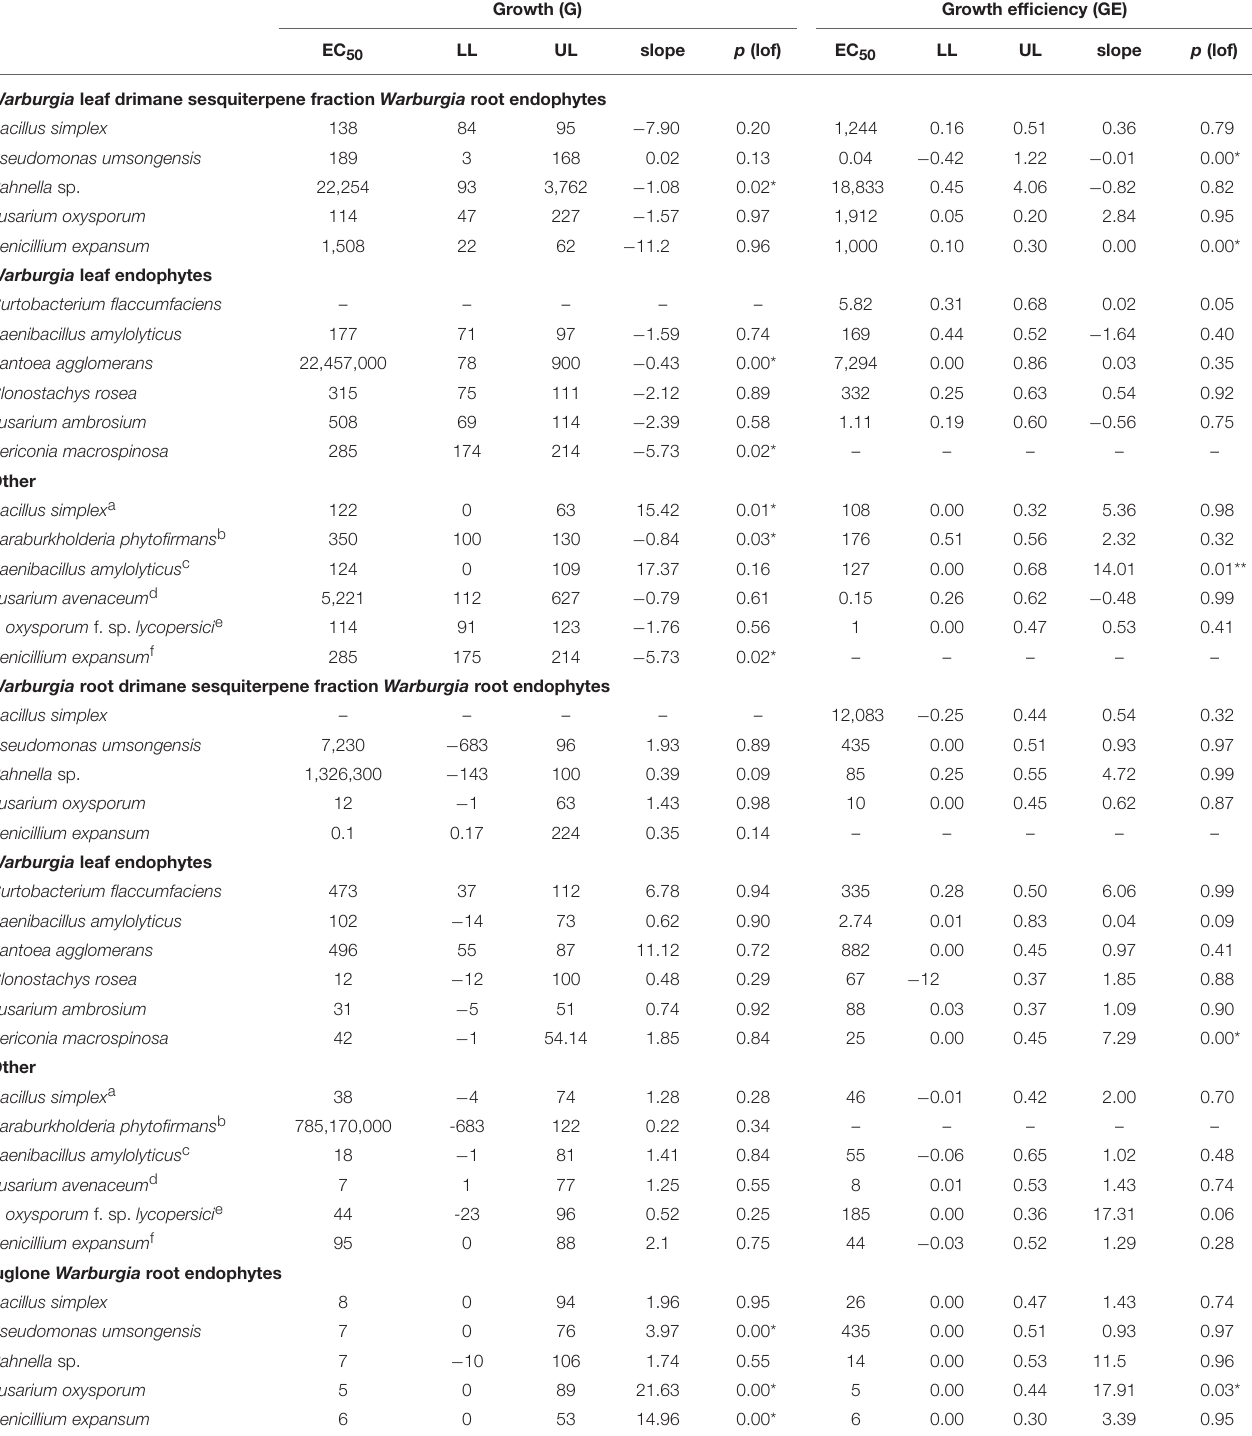
TABLE 2 | Growth susceptibility (G) and growth efficiency (GE): EC 50 ( µ g mL − 1 ), LL (lower limit, µ g mL − 1 ), UL (upper limit, µ g mL − 1 ), slope (of sigmoidal dose–response curve), p (lack-of-fit